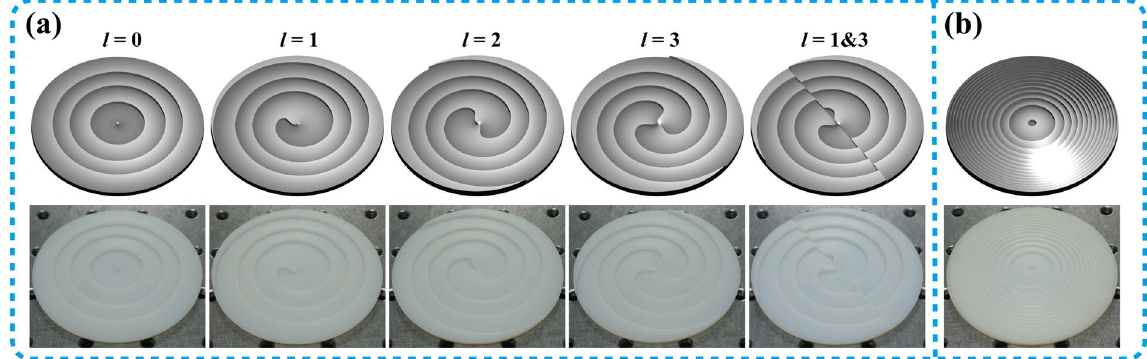
Figure 2. The height profiles of the diffractive phase plates. The CAD models (top row) and the photos (bottom row) of ( a ) The first phase plates (R1) and ( b ) The second phase plate (R2). The parameter α = 8.7266 × 10 − 4 , β = 9.5155. The diameter and the maximum height of these plates are 76.2 mm and 3.53 mm, respectively.